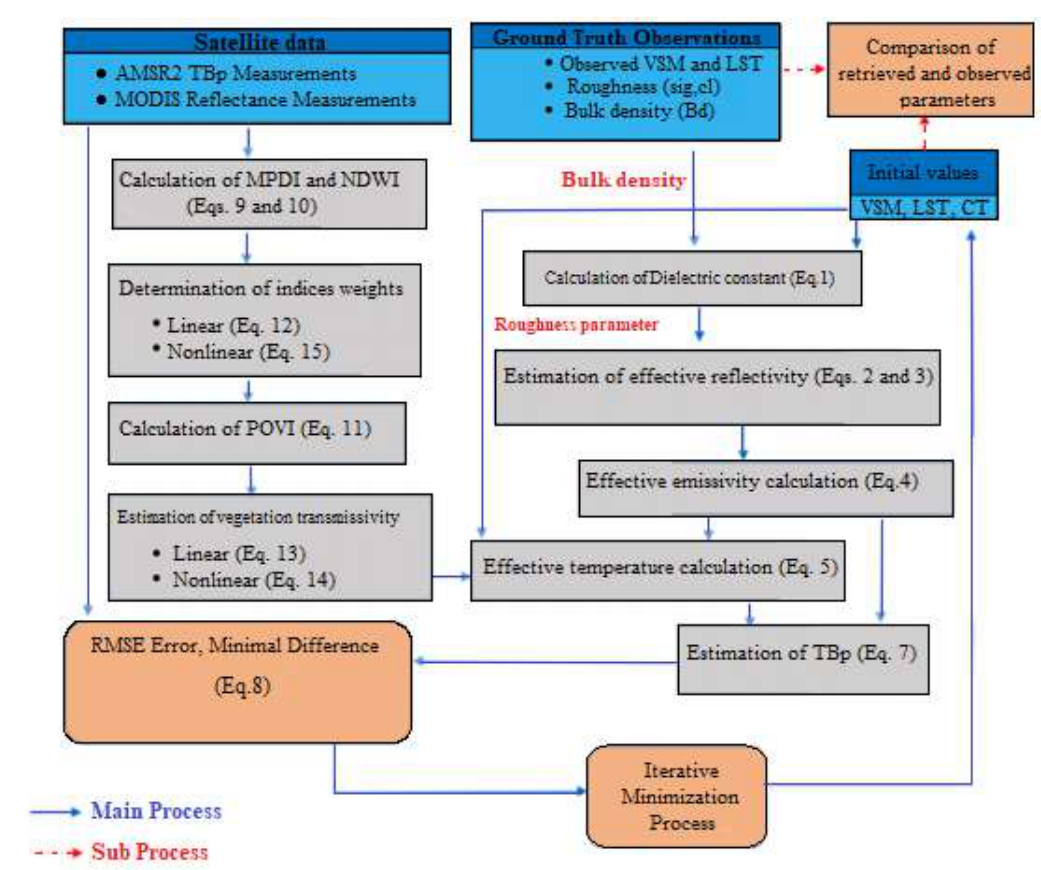
Figure 5. Workflow employed in this